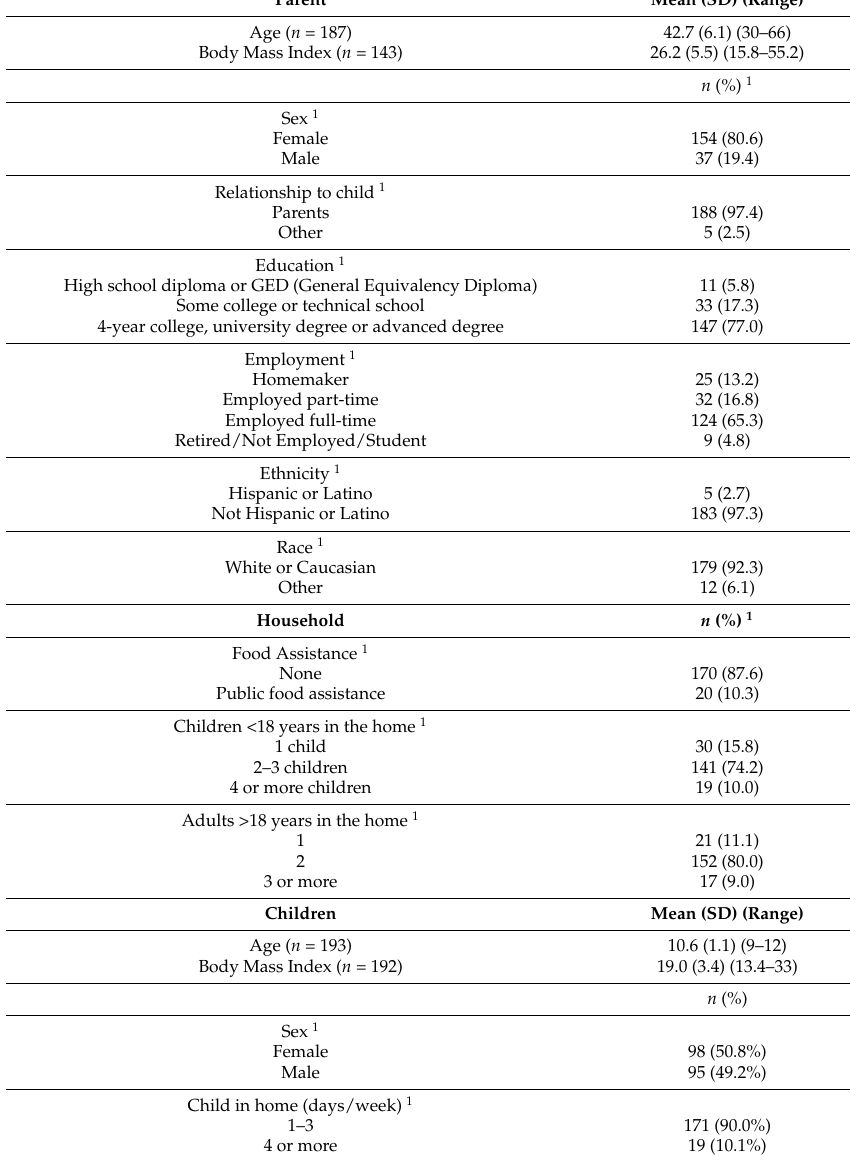
Table 1. Demographic characteristics of parent and child participants in a cross-sectional